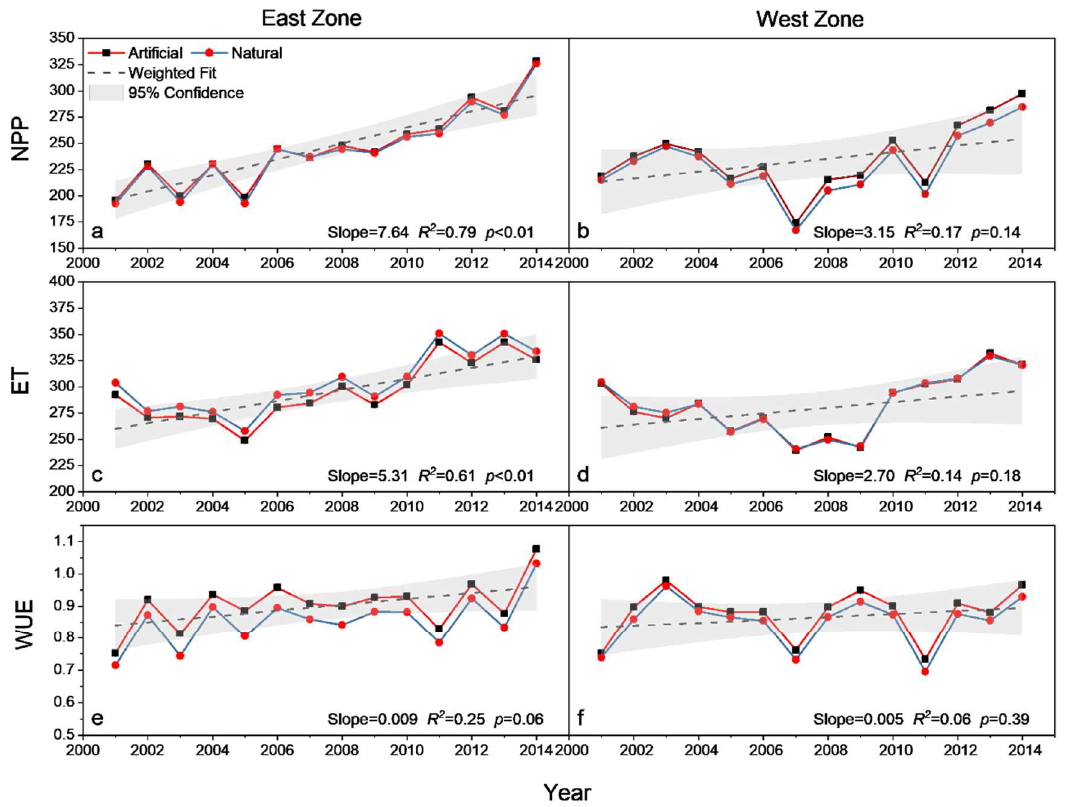
Figure 4. Annual mean NPP, ET and WUE in artificial forested (red line) and natural forested (blue line) East Zone ( a , c , e ) and West zone ( b , d , f ) in